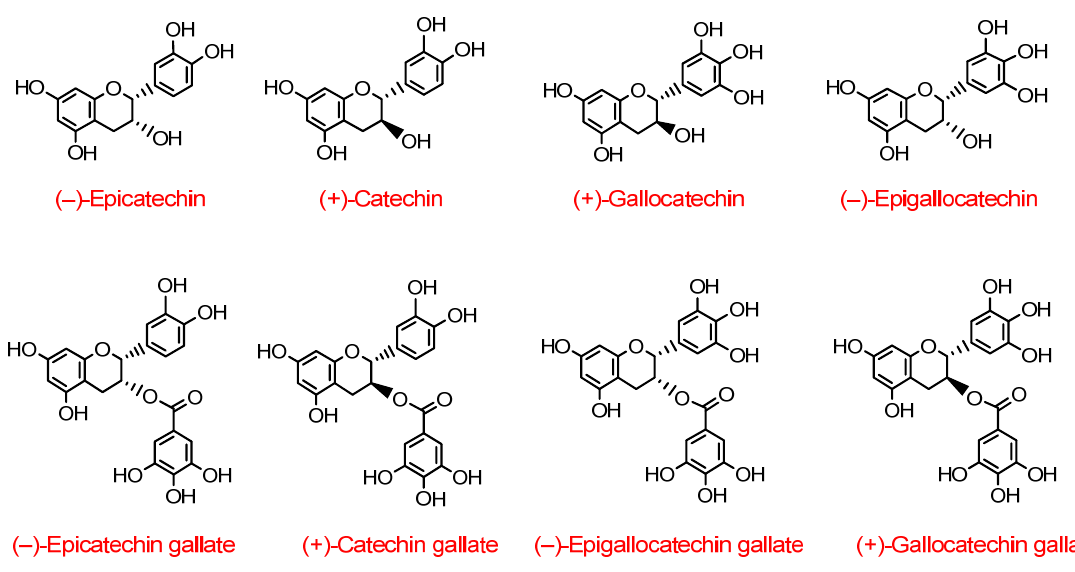
Figure 4 . Structures of green tea flavan-3-ols.